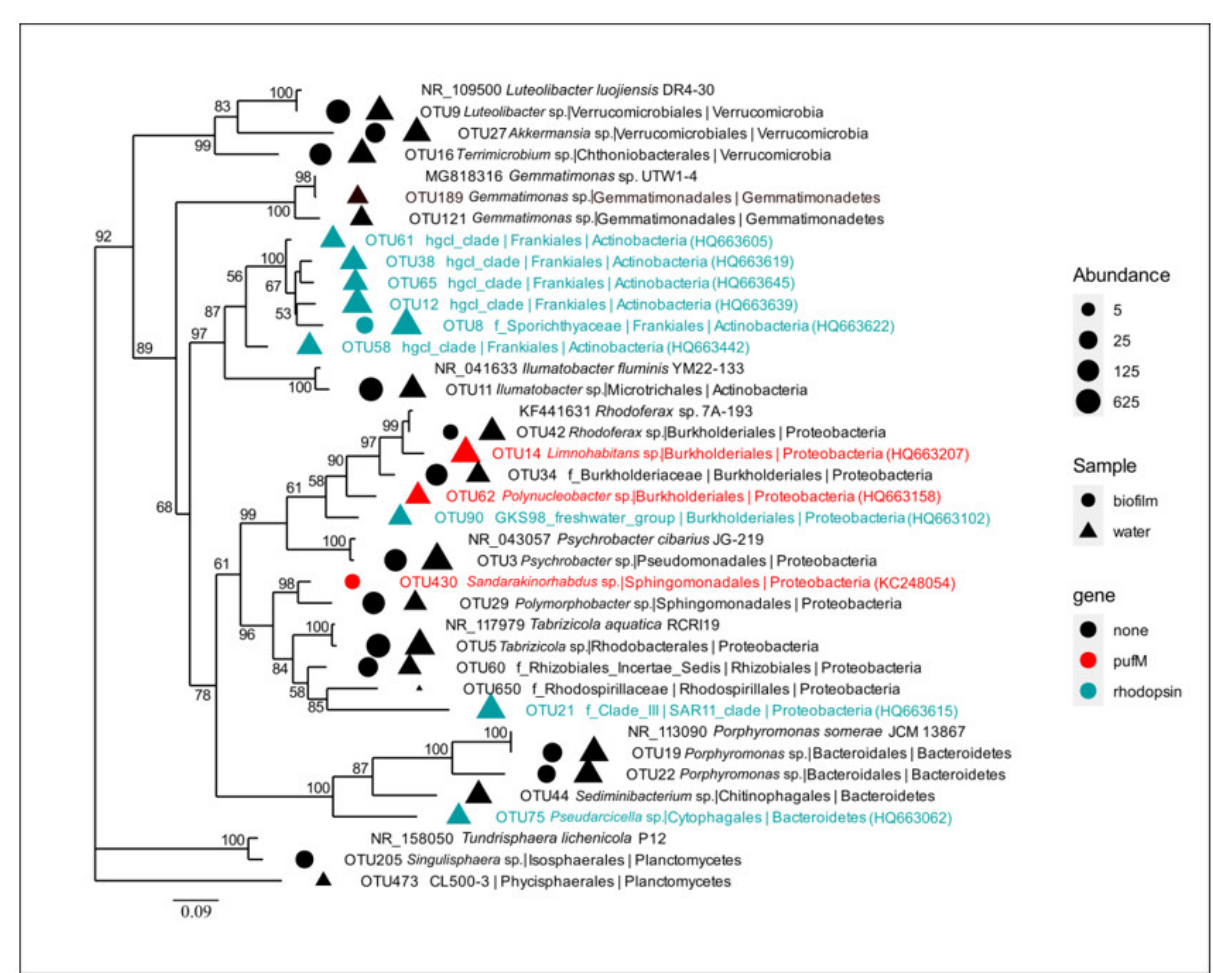
Figure 8. Maximum-Likelihood tree of 16S rRNA gene alignment with the closest homologues for the most abundant and potentially phototrophic OTUs. Circles and triangles are representing biotope type and colors are showing presence (blue and red) or absence (black) of the functional gene in reference organism (similarity 99–100%). The size of the circle/triangle corresponds to the number of sequences belonging to the OTU in the epilithic biofilm/water microbial communities, re- spectively.